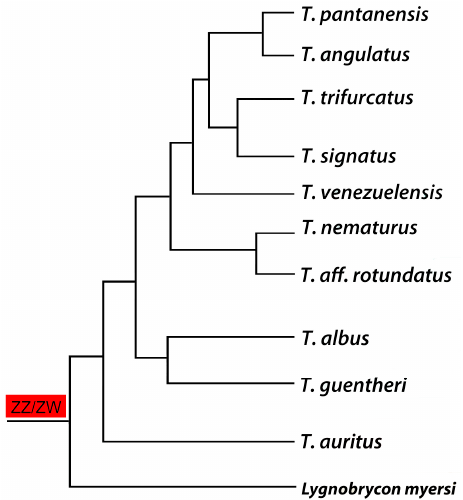
Figure 4. Phylogenetic tree for the Triportheus genus (based on the data generated by [63]) highlighting the presence of a ZZ/ZW sex chromosome system in all analyzed species. Note that Lignobrycon myersi corresponds to the sister group of all other Triportheidae species and also possesses a similar ZW sex chromosome system, suggesting an early origin of this system in the family.